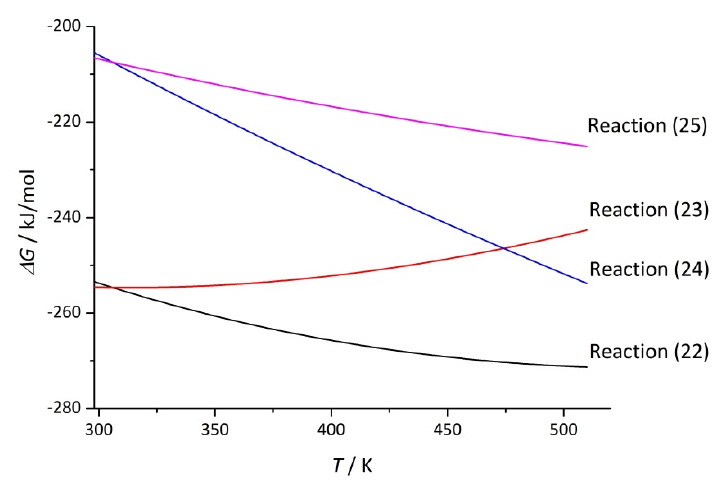
Figure 4. Temperature dependences of the change in the Gibbs energy in rutile dissolution reactions in 100% sulfuric acid, with NaF as the activator reagent. Each curve corresponds to the individual reaction.